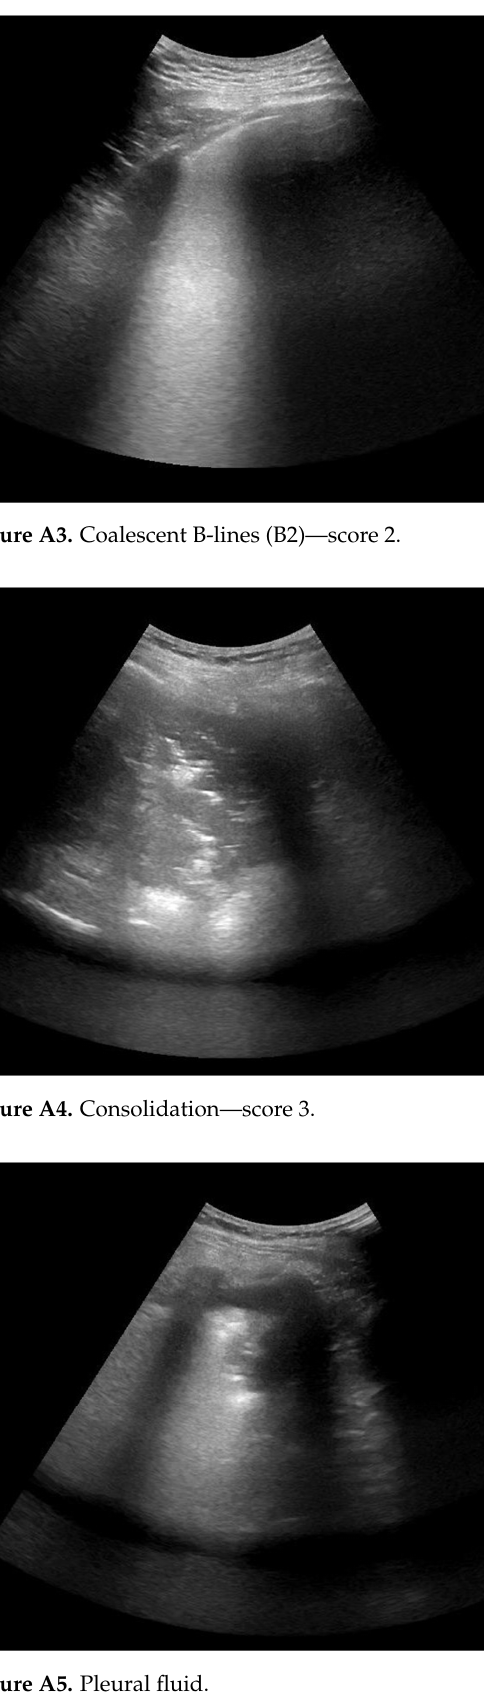
Figure A2. Well-spaced B-lines (B1)—score 1.